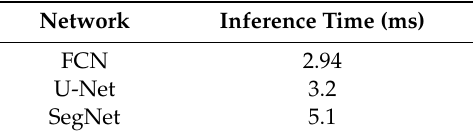
Table 6. Inference time of di ff erent segment networks on